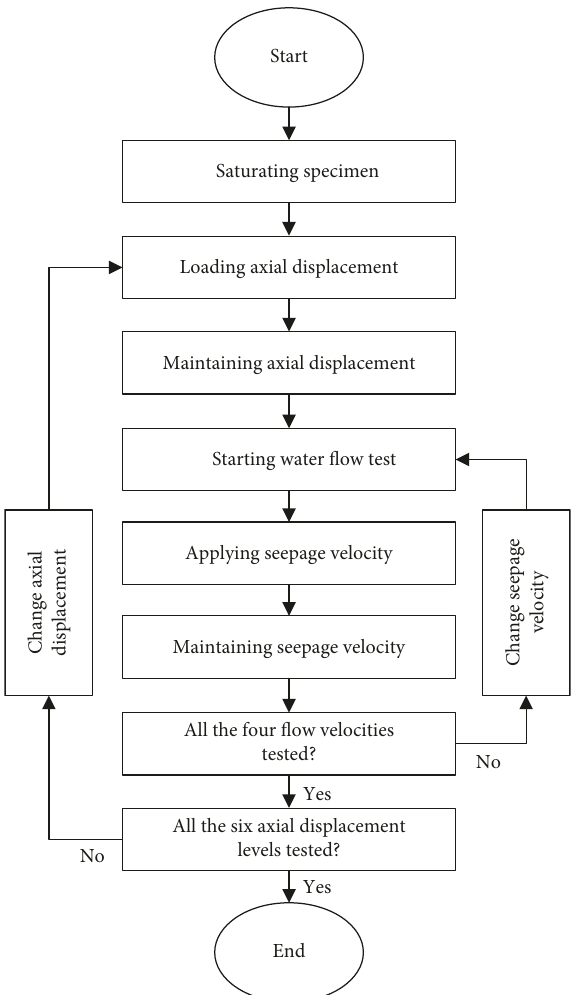
Figure 3: Water flow testing procedure of the crushed sandstone and mudstone